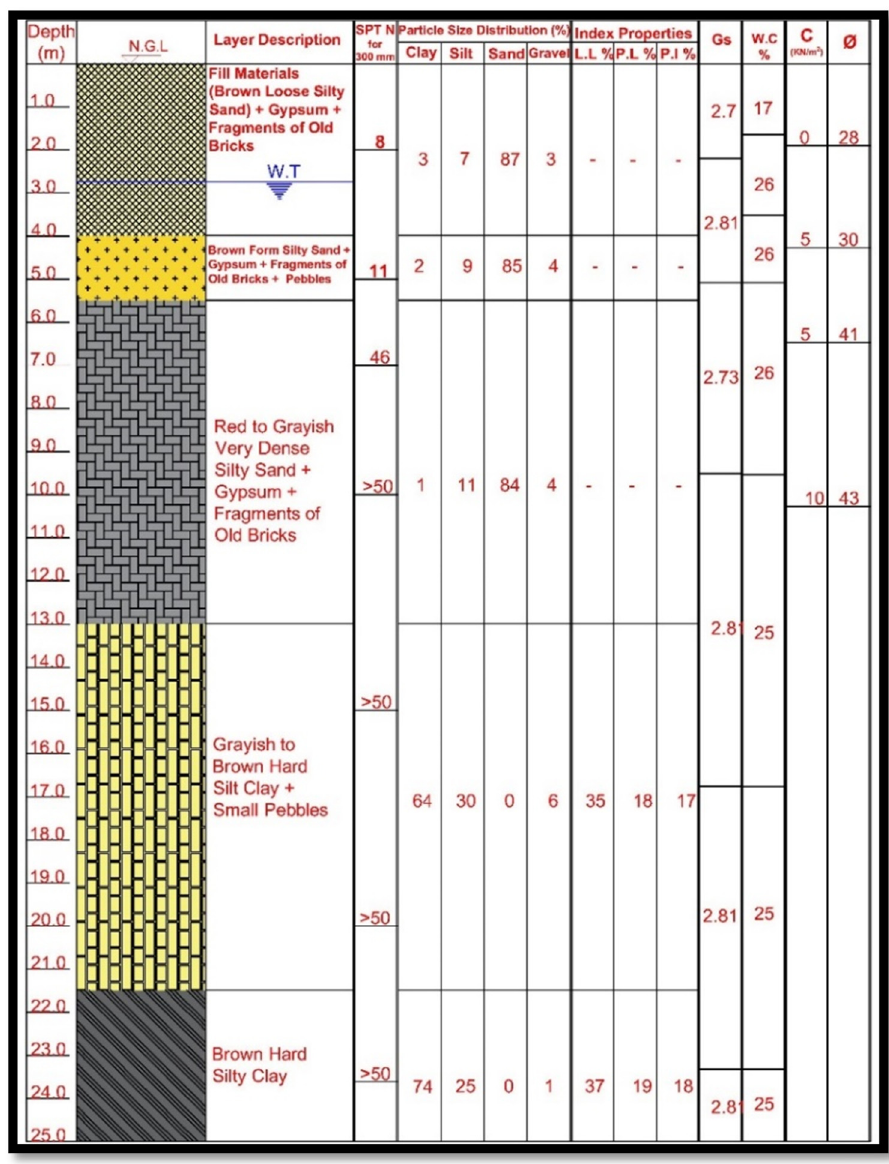
Figure 3: Soil pro fi le of Al - Kufa